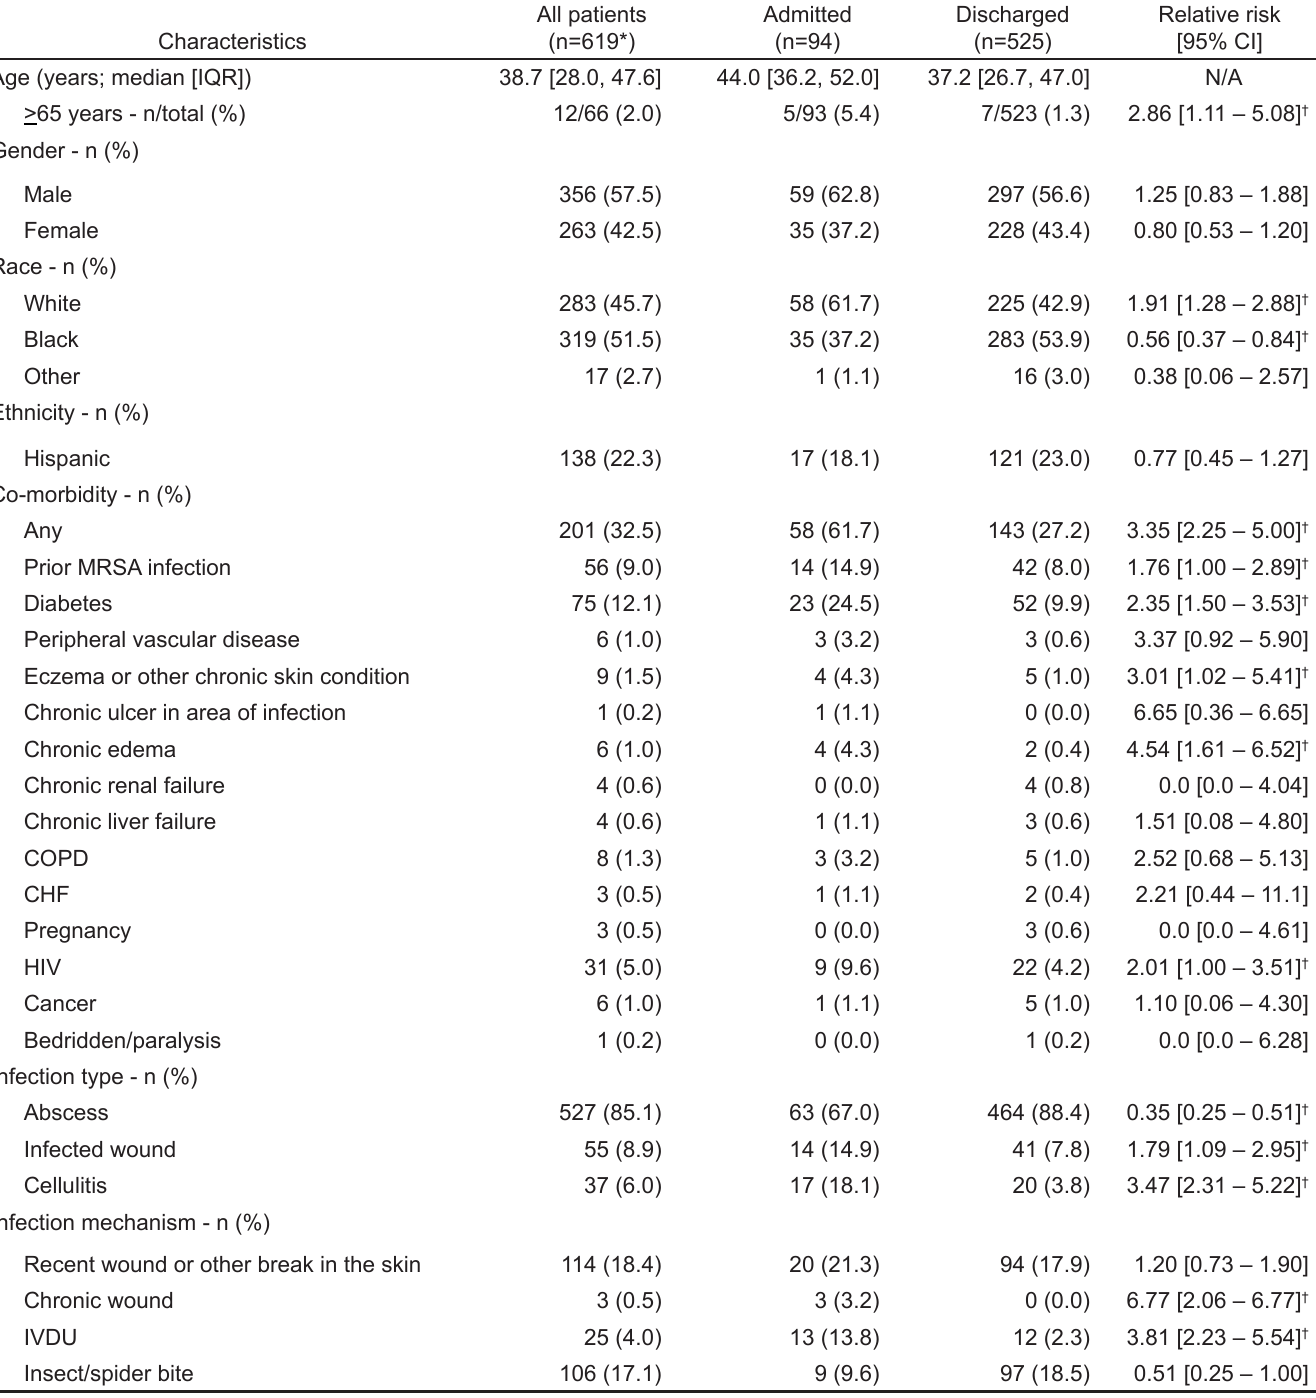
Table 1. Demographic and clinical characteristics of 619 U. S. emergency department patients with a skin and soft tissue infection, by admission or